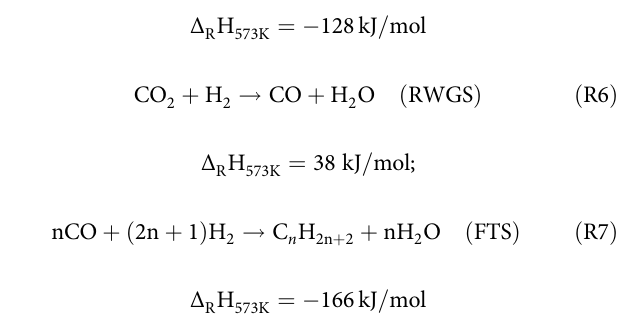
Fig. 2 CO 2 hydrogenation to C 2 + products via the FTS-based mechanism. a Scheme of CO 2 modi fi ed FTS-based catalytic mechanism. b – d CO 2 hydrogenation via the FTS mechanism for production of light ole fi ns, liquid fuels, and higher alcohols 76 – 78,91,98 . e Synthesis strategy for an Fe-based catalyst. (Reprinted with permission from Ramirez et al. 83 . Copyright (2018) American Chemical Society). f Selective production of aromatics from the CO 2 hydrogenation process over a ZnFeO x – n Na/HZSM-5 catalyst. (Reprinted with permission from Cuiet al. 93 . Copyright (2019) American Chemical